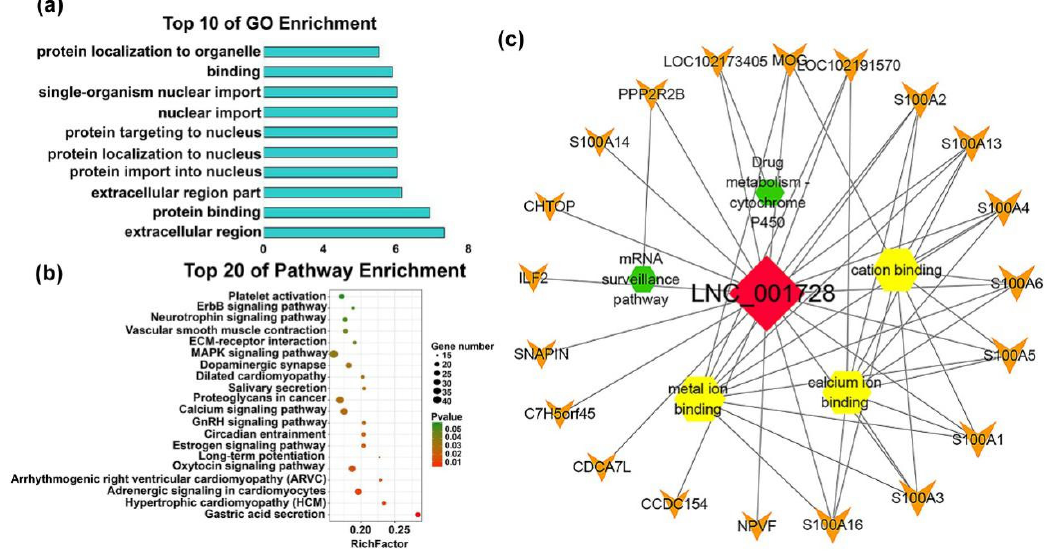
Figure 7. Functional and pathway enrichment of module 1. ( a ) Bar plots showing the top 10 enriched GO terms in M1. The length of the bars indicates significance ( − log 10 P -value). ( b ) Top 20 enriched gene pathway terms of the all M1 lncRNAs. ( c ) Function network of the LNC_001728. The green hexagonal denotes the pathway analysis, yellow hexagonal denotes enriched GO terms, red diamond represents lncRNA, orange V shape represents mRNAs, and the size is expressed in degrees.